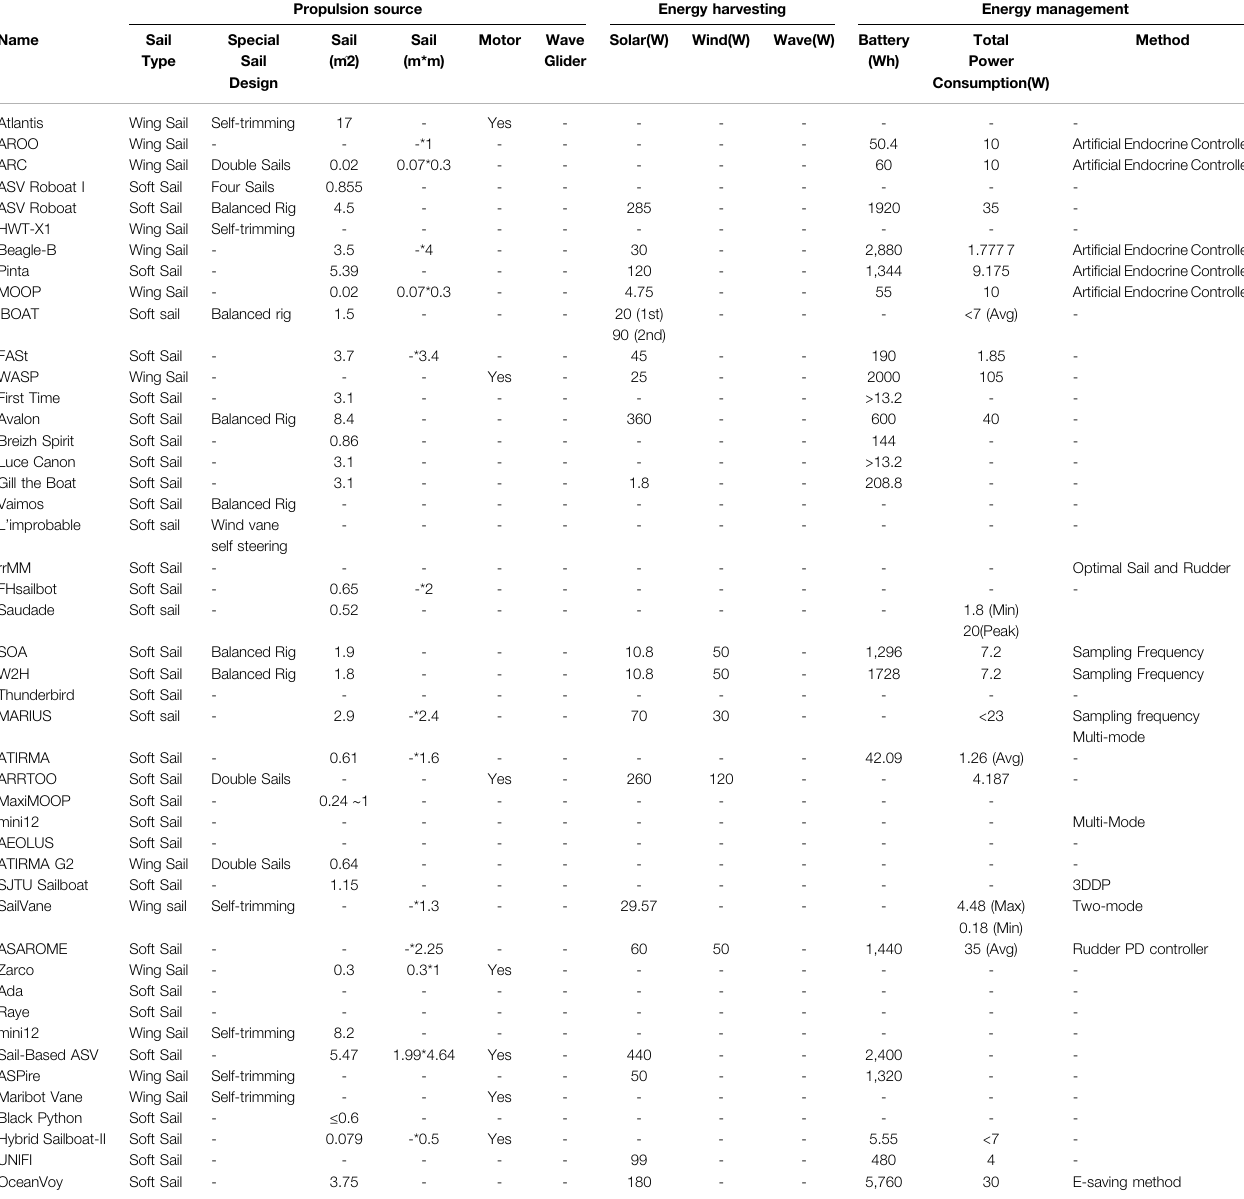
TABLE 2 | The sailboats con fi guration about propulsion source, energy harvesting and energy management in different research groups. Propulsion source Sail